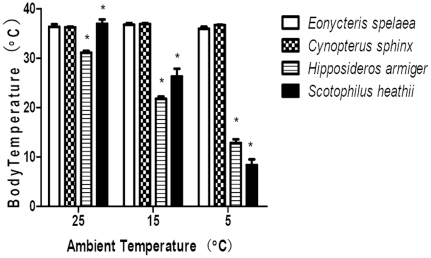
Comparison of body temperature of four bats as a function of ambient temperature.
Eonycteris spelaea (N = 6), Cynopterus sphinx (N = 6), Hipposideros armiger (N = 6) and Scotophilus heathii (N = 6). The SE is indicated by the error bars. *P<0.0001.